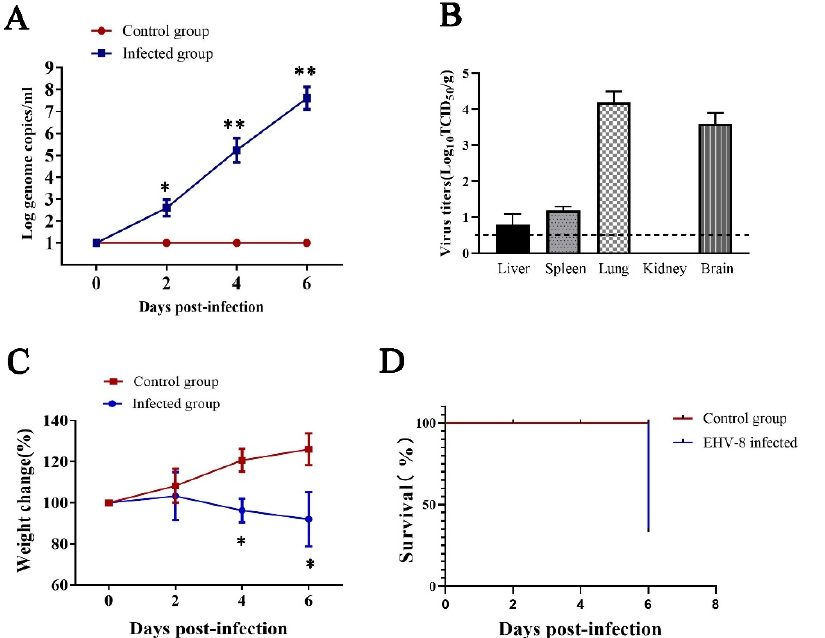
Figure 2. The EHV-8 replicates efficiently in BALB/c mice. Viremia was detected in serum at the indicated time points ( A ). EHV-8 replication in tissues at 6 dpi was also tested by titrating on RK-13 cells ( B ), body weight ( C ), and mortality ( D ). The data shown are representatives from three inde- pendent experiments and subjected to Student’s t -test. * p < 0.05 vs. the control group mice at the same time point; ** p < 0.01 vs. the control group mice at the same time point.